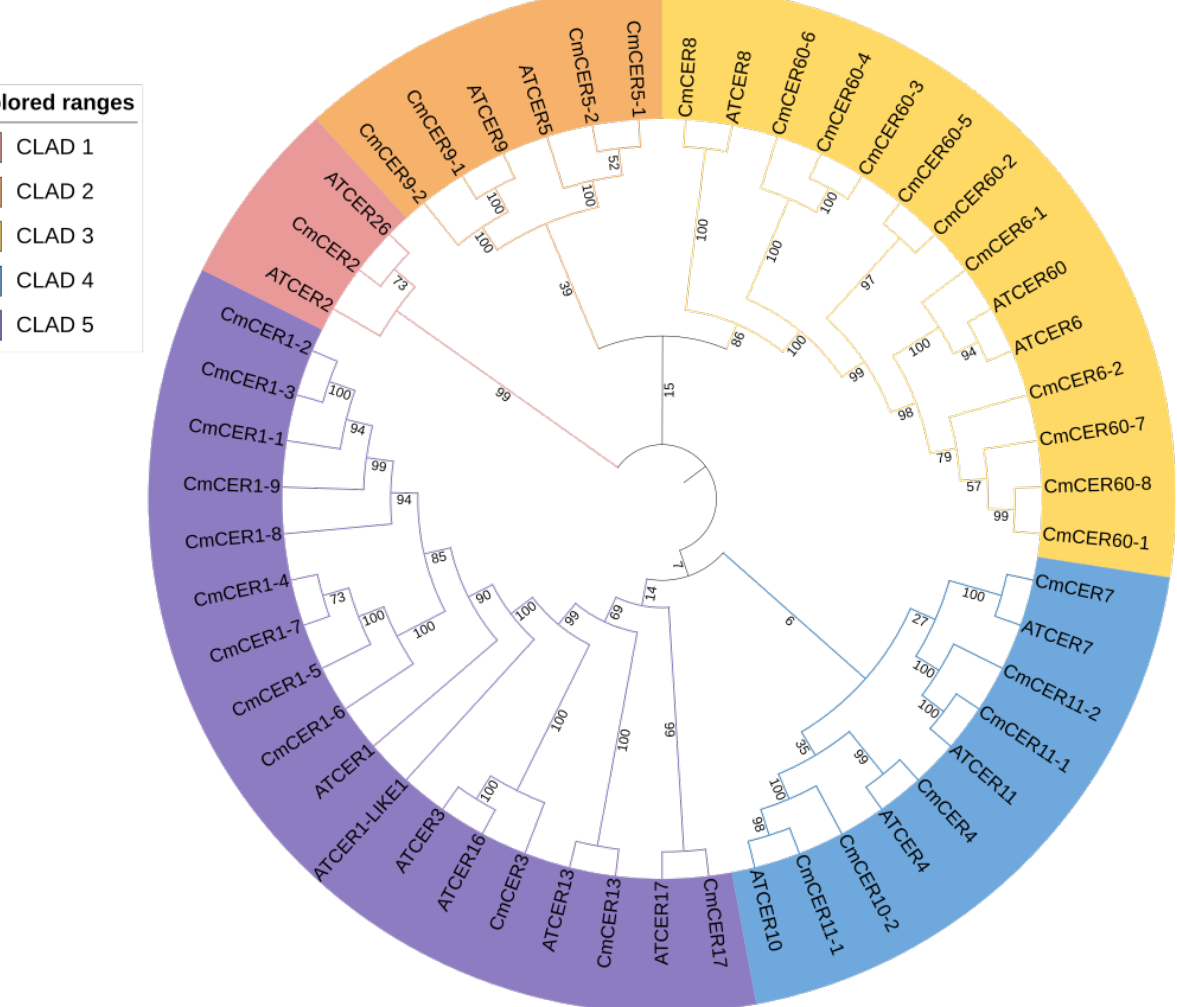
Figure 3. Phylogenetic trees of 17 CERs in A. thaliana and 34 CERs in C. mollissima . MEGA11 was applied to construct the maximum-likelihood (ML) tree using the WAG with Freqs. (+F) model with 1000 bootstrap replicates. The number on the branch indicates the bootstrap value. The different groups are color-coded as indicated in the top left panel.